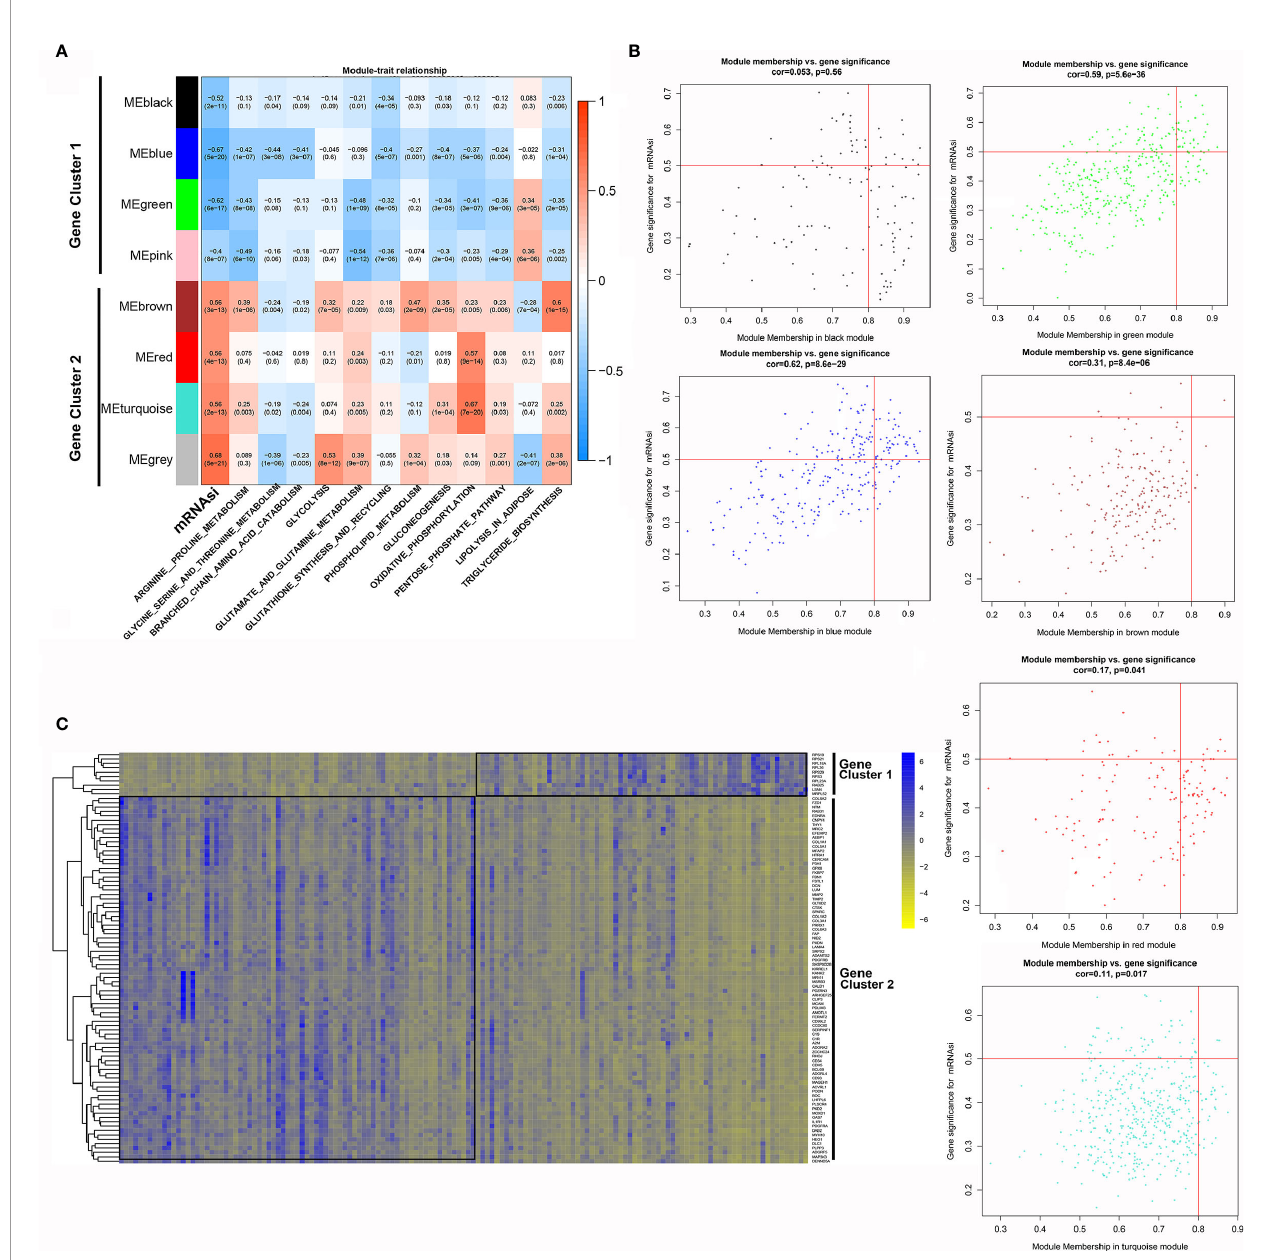
FIGURE 4 | WGCNA-based identi fi cation of gene modules and key genes associated with PDAC stemness. (A) Module-trait relationships revealed the correlations among gene modules, mRNAsi and metabolic pathways. (B) Identi fi cation of key genes signi fi cantly associated with both mRNAsi and modules in each gene module. (C) The differential expression of the selected key genes between the mRNAsi_high and mRNAsi_low